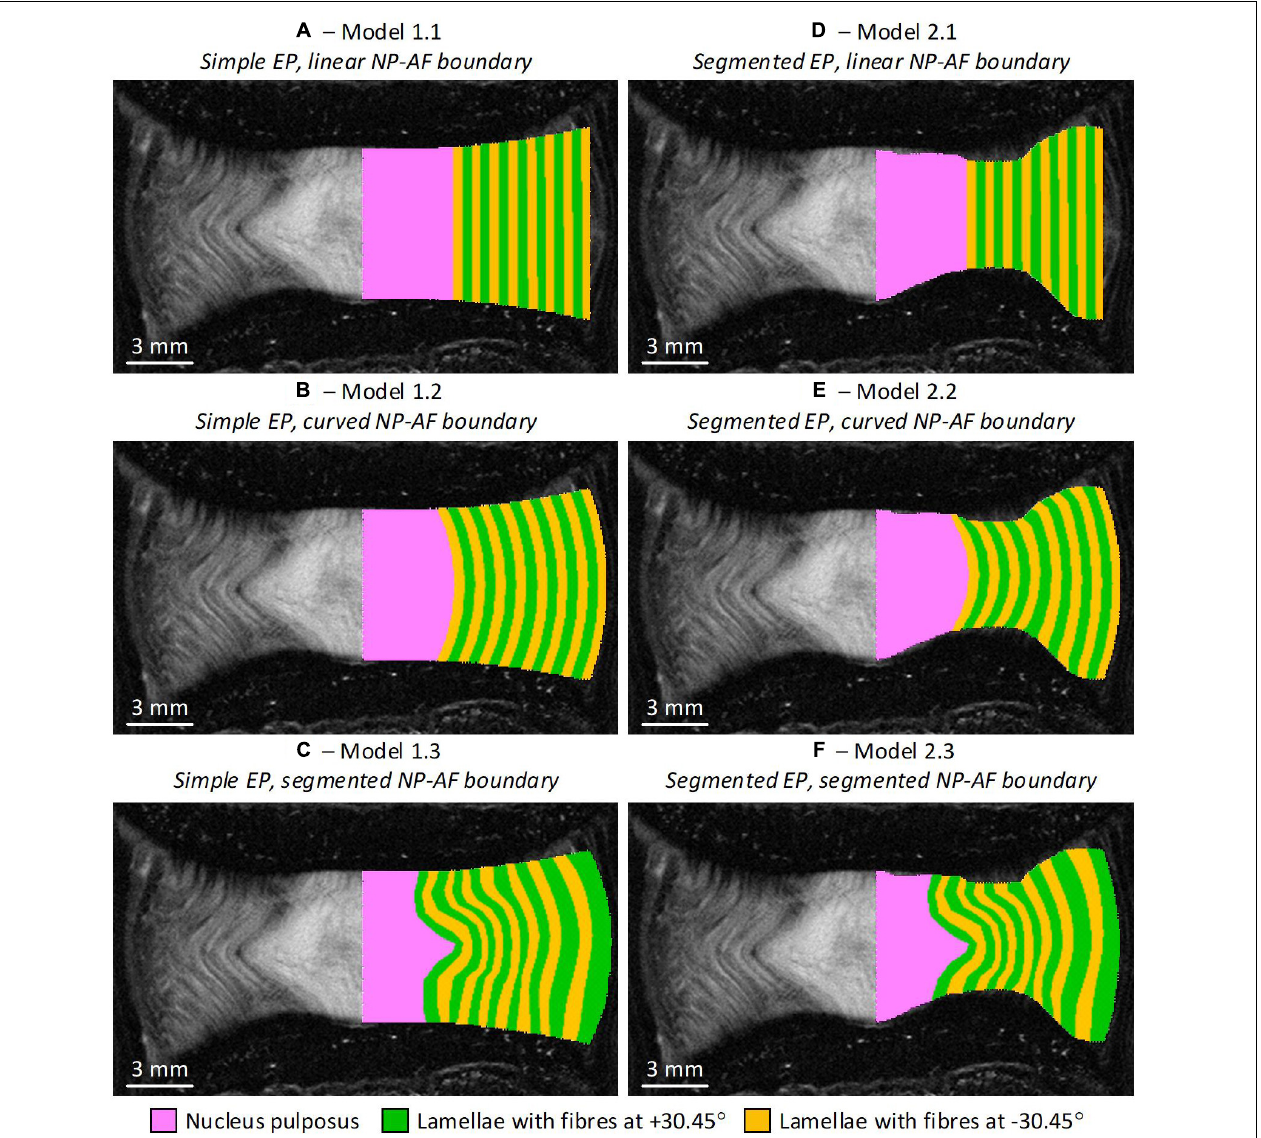
FIGURE 2 | Initial geometry of the six axisymmetric FE models overlaid on the MRI slice from which the geometries were obtained. Note the axis of symmetry in the models is along the mid-sagittal plane of the IVD. (A) Model 1.1—simple endplates, linear NP-AF boundary, (B) Model 1.2—simple endplates, curved NP-AF boundary, (C) Model 1.3—simple endplates, segmented NP-AF boundary, (D) Model 2.1—segmented endplates, linear NP-AF boundary, (E) Model 2.2—segmented endplates, curved NP-AF boundary, (F) Model 2.3—segmented endplates, segmented NP-AF boundary. Note the fibre bundle angles are relative to the transverse